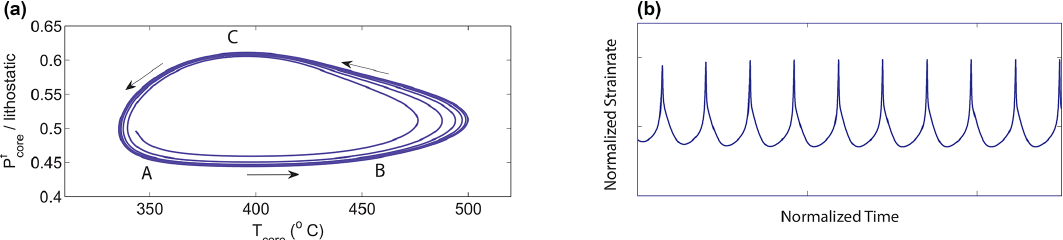
Figure 3. The characteristic period of the Cascadia ETS sequence interpreted with a reaction–diffusion oscillator model (Poulet et al., 2014b). (a) The phase diagram between A and B corresponds to the slow creep of the serpentinite slowly raising the temperature to the critical level for the onset of the dehydration reaction. The segment between B and C corresponds to the dehydration reaction that coincides with the tremor and slips event. The following segment between C and A is the diffusion-dominated field. (b) The corresponding normalized strain rate with the sharp peak corresponding to the tremor